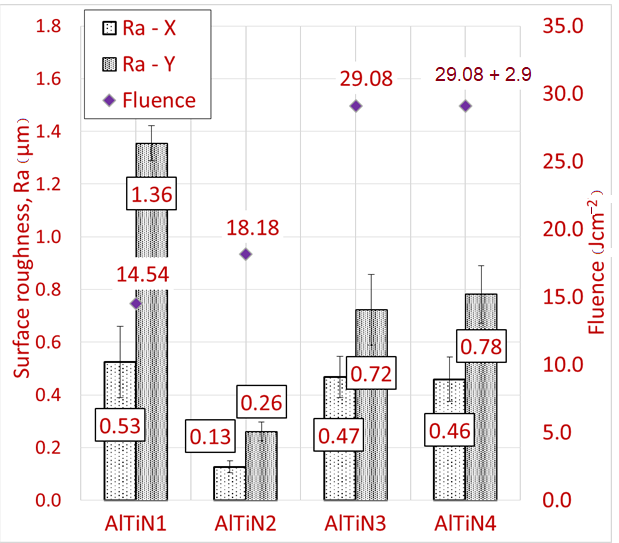
Figure 4. Bar chart of surface roughness after laser stripping of the AlTiN coating in relation to the fluence.